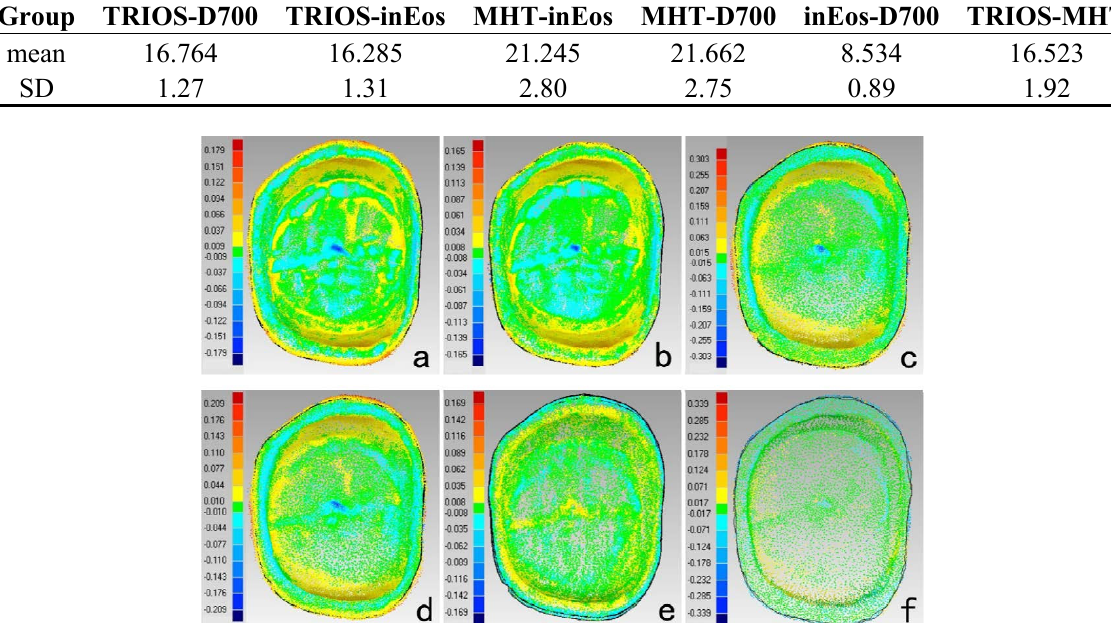
Figure 3. Color-coded difference images showed the deviations between